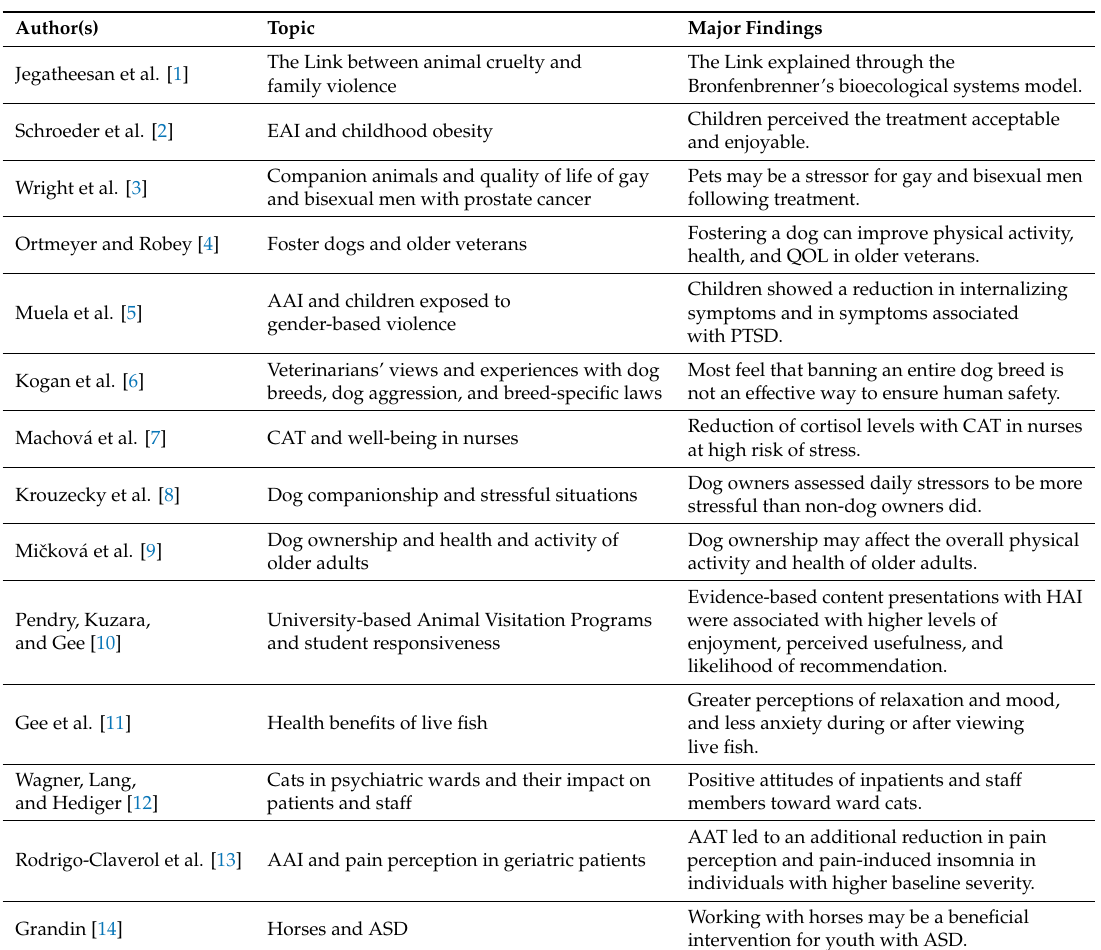
Summary of Articles Submitted in the Special Issue “The Psycho-Social Impact of Human-Animal